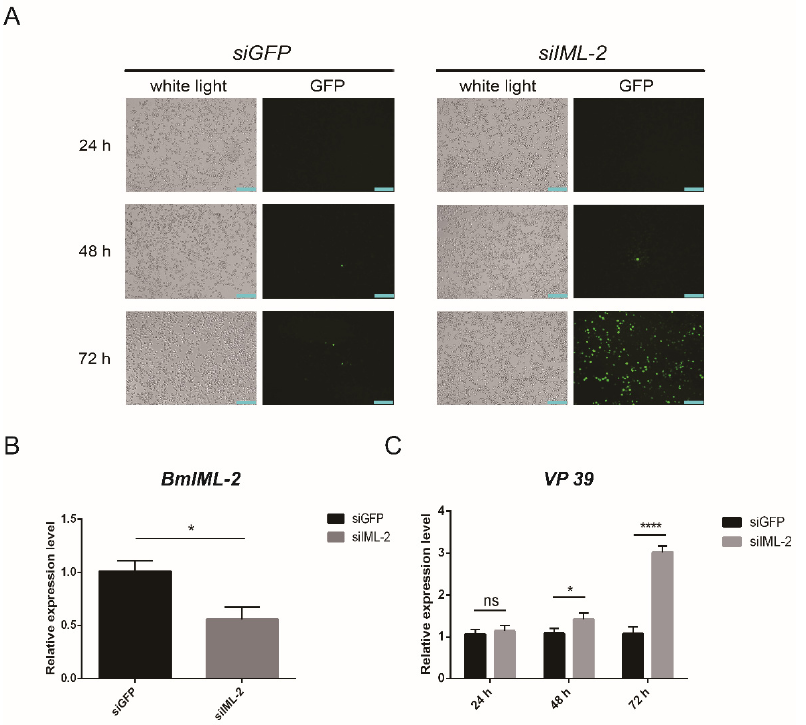
Figure 5. Effects of BmNPV infection and replication by knockdown of BmIML-2 in BmN cells. ( A ) The infected cells after knockdown of BmIML-2 were observed under a fluorescence microscope. White light, optical transmission; GFP, green ; mCherry, red ; scale bar = 200 µm. ( B ) Transcript level analysis of BmIML-2 at 48 h after transfection of siRNA. ( C ) Transcript level analysis of VP 39 after knockdown of BmIML-2 at different times. Data were calibrated by using BmGAPDH and pre- sented as means ± S.D. of three separate experiments. Asterisks represent significant differences compared the control (unpaired t -test; *, p < 0.05; ****, p < 0.0001; ns, not significant). Conflicts of Interest: The authors declare no conflict of interest . Reference 1.